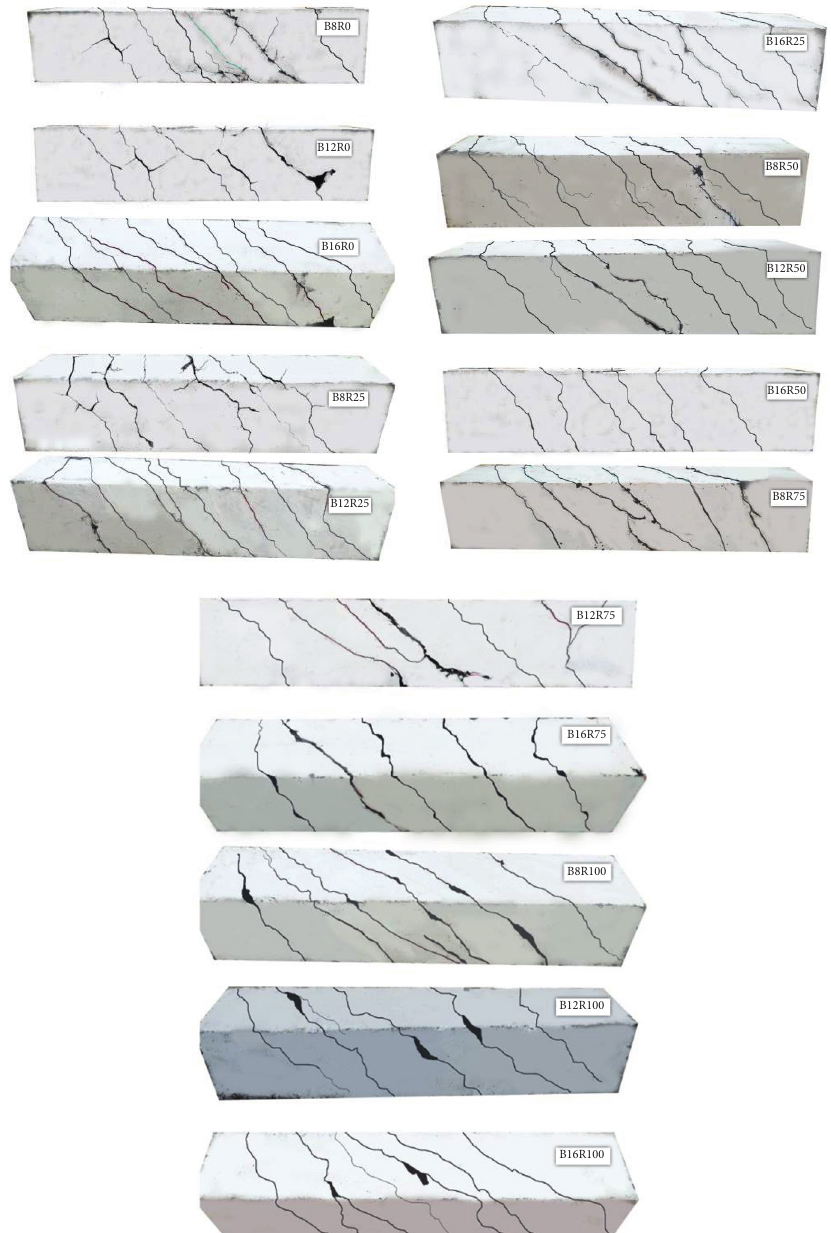
Figure 10: Crack patterns of all tested